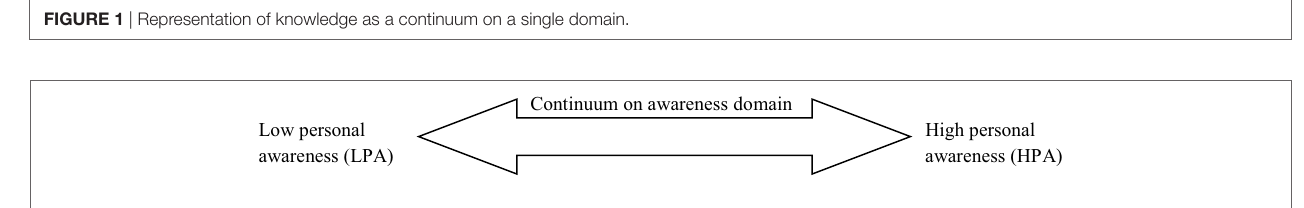
FigUre 2 | Representation of awareness as a continuum on a single